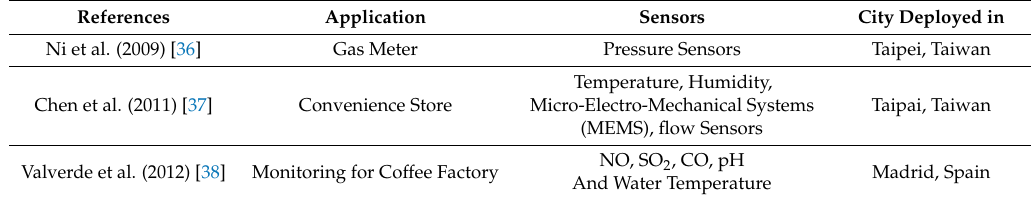
Table 3. Examples of prototyped applications for industrial and business uses.